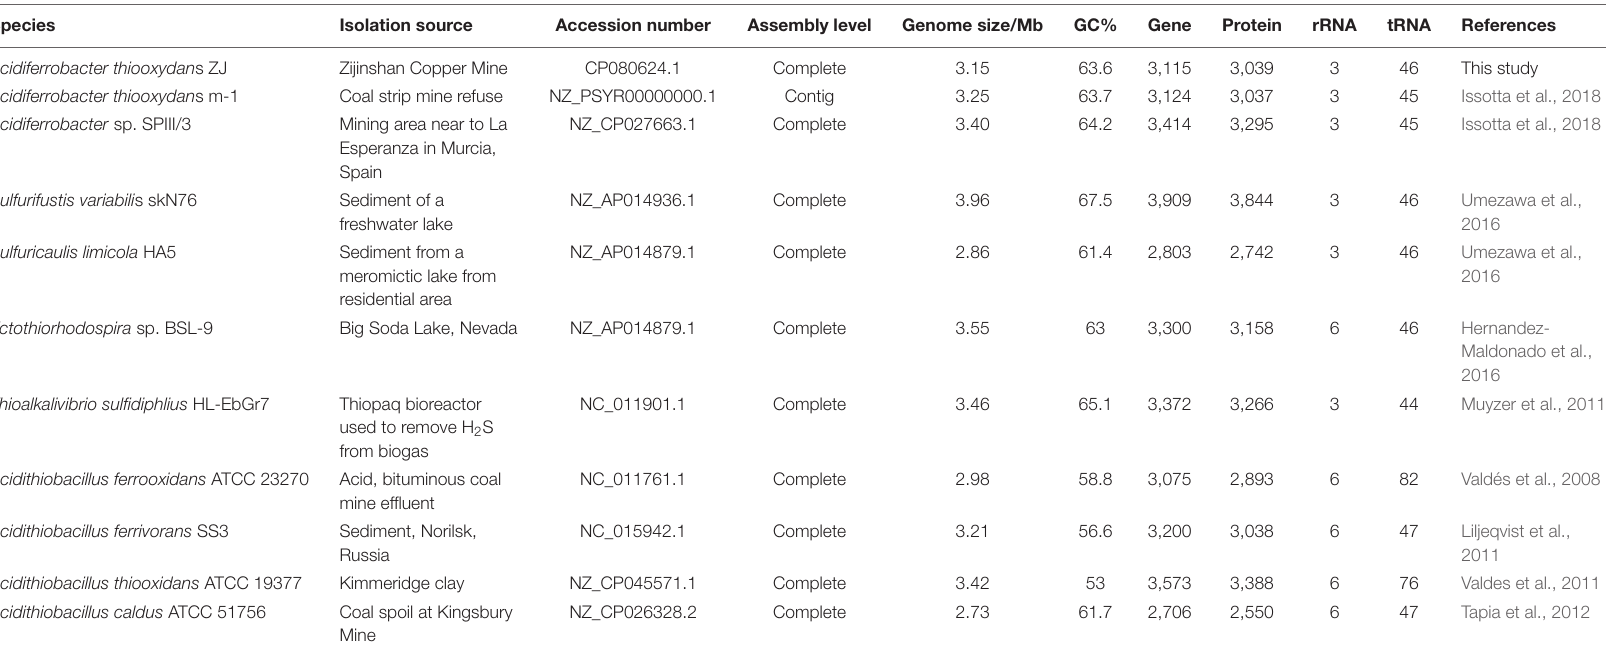
TABLE 1 | Overview of the complete genomes selected from Ectothiorhodospiraceae and Acidithiobacillaceae